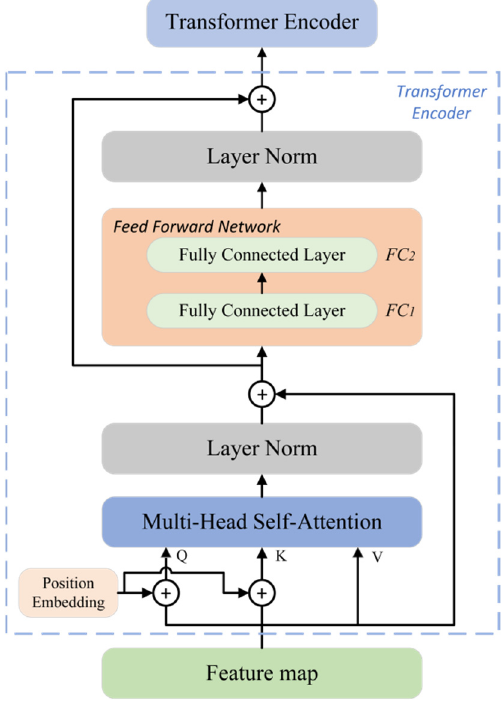
Figure 2. The overall architecture of Transformer encoder. We use absolute position embedding in Transformer encoder.